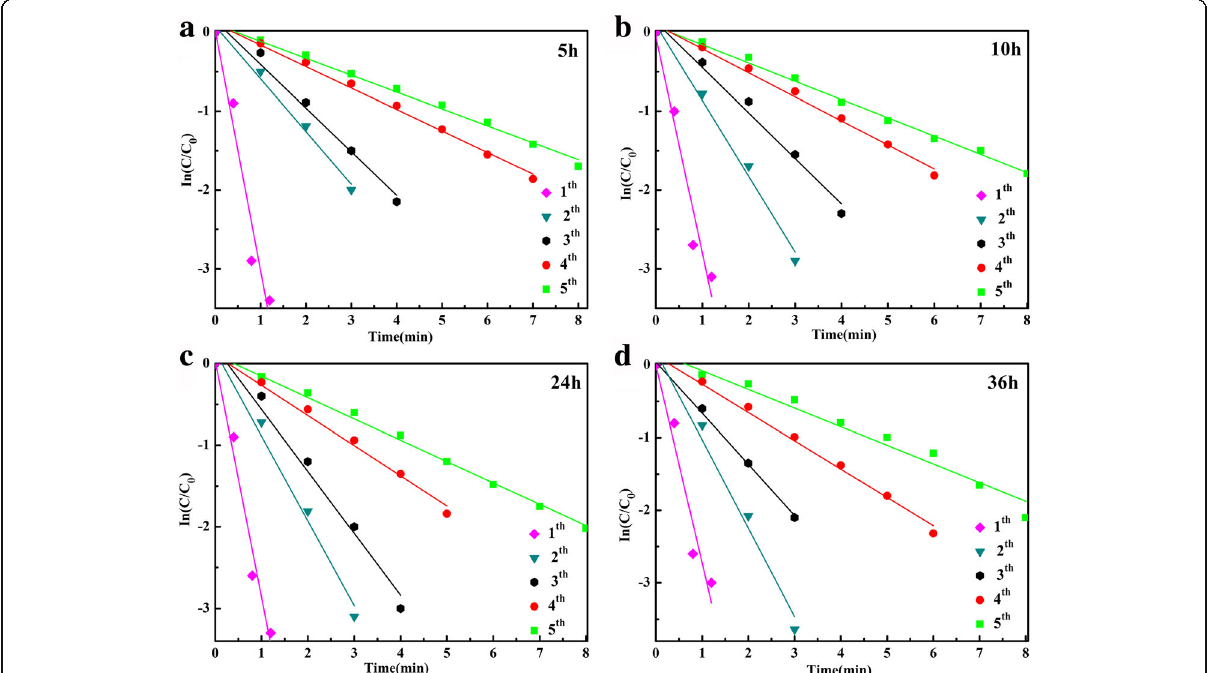
Fig. 7 Plot of ln( C t / C 0 ) versus reaction time in the presence of Ag-decorated SnO 2 microspheres prepared for different hydrothermal times a 5 h, b 10 h, c 24 h, and d 36